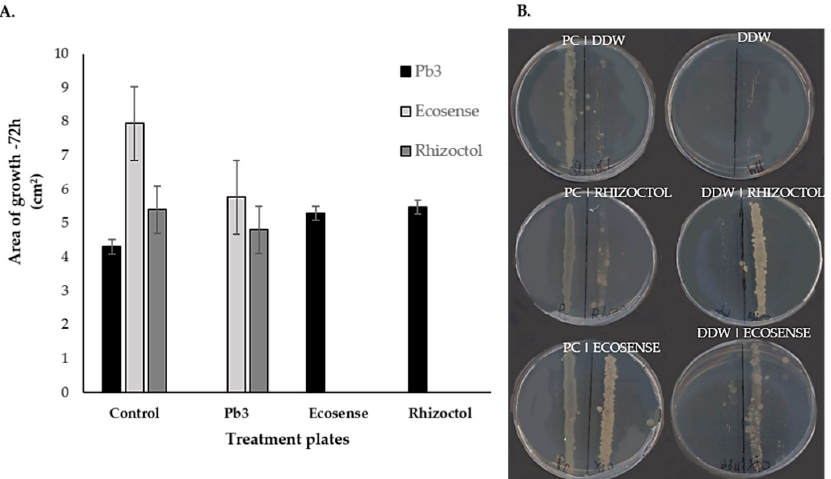
Figure 6. Differences in the area populated by Bacillus and Pectobacterium brasiliense (Pb3) on solid LB agar. Bacillus subtilis from Ecosense or Rhizoctol products were plated on LB plates by spreading a 10 µ L droplet, or 10 µ L of Pb3 at a concentration of 1 × 10 8 CFU/mL or 10 µ L of sterilized water. There were five replicates of each combination of Bacillus, Pb3 or water. ( A ) Comparison of the average area covered by each bacterial treatment (Pb3/Ecosense/Rhizoctol) or water (negative control) on a Petri dish, as measured at 72 h post-inoculation following incubation at 28°C. The bars represent the standard errors for each treatment. Statistical variance was tested by a t -test at a significance level of p < 0.05. ( B ) Representative images of the experiment plates at 72 h post-inoculation. Left column (top to bottom): Pb3 vs. water (DDW); Pb3 vs. B. amyloliquefaciens (Rhizoctol); Pb3 vs. Bacillus subtilis (Ecosense). Right column (top to bottom): water (DDW) only; B. amyloliquefaciens (Rhizoctol) vs. water (DDW); B. subtilis (Ecosense) vs. water (DDW).